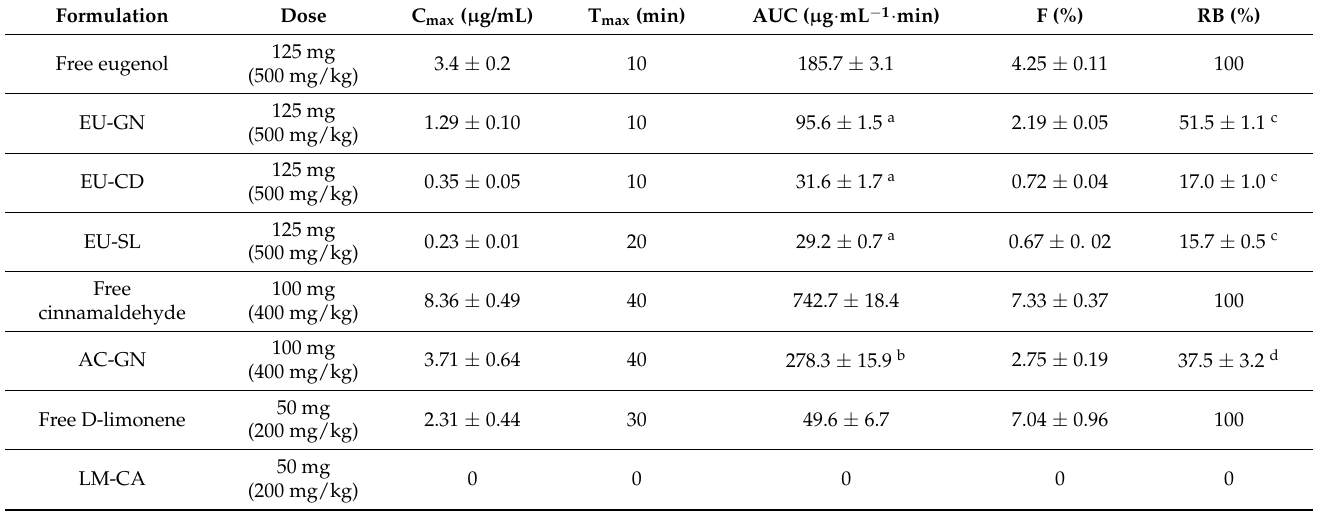
Table 3. Pharmacokinetic parameters referred to the bloodstream of eugenol, cinnamaldehyde and D-limonene after oral administration to rats. Data are reported as mean ± SE ( n = 4). C max : maximum concentration obtained in the bloodstream; T max : time of C max ; AUC: area under concentration from time 0 to infinity; F: absolute bioavailability; RB: relative bioavailability.